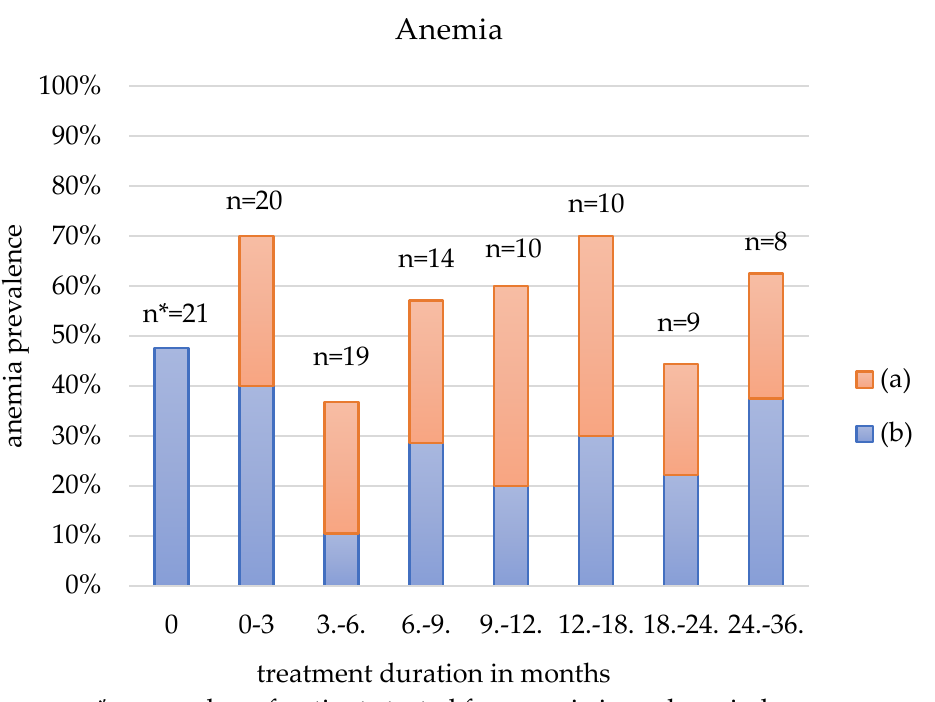
Figure 1. Anemia according to the treatment duration in patients with: (a) no history of anemia prior to sirolimus treatment, (b) a history of anemia prior to sirolimus treatment.